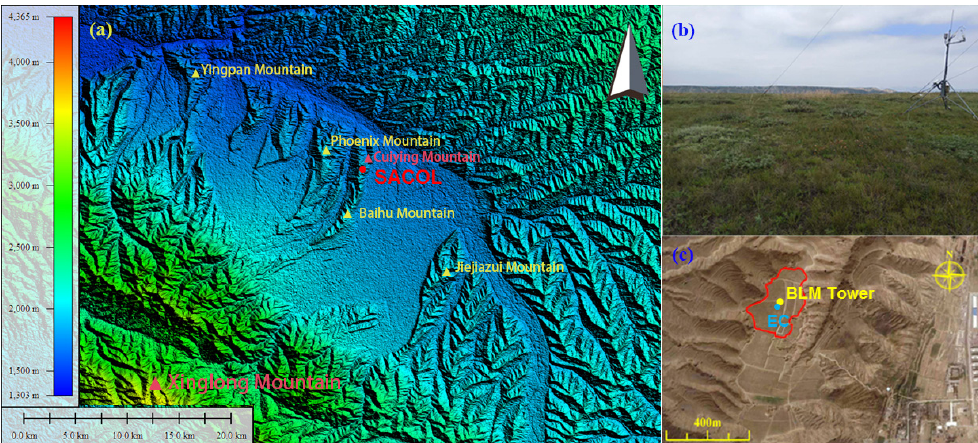
Figure 1. ( a ) The topographic map of the Semi-Arid Climate and Environment Observatory of Lanzhou University (SACOL), ( b ) the area surrounding the observation field obtained from Google Earth, and ( c ) the vegetation of the flux observation field in summer. The area surrounded by the yellow line is the observation field, and circles filled with yellow and blue represent the locations of the boundary layer meteorological tower (BLM tower) and the eddy covariance system (EC). The topographic map in Figure 1 ( a ) is drawn using ASTER GDEM v2 data [25].